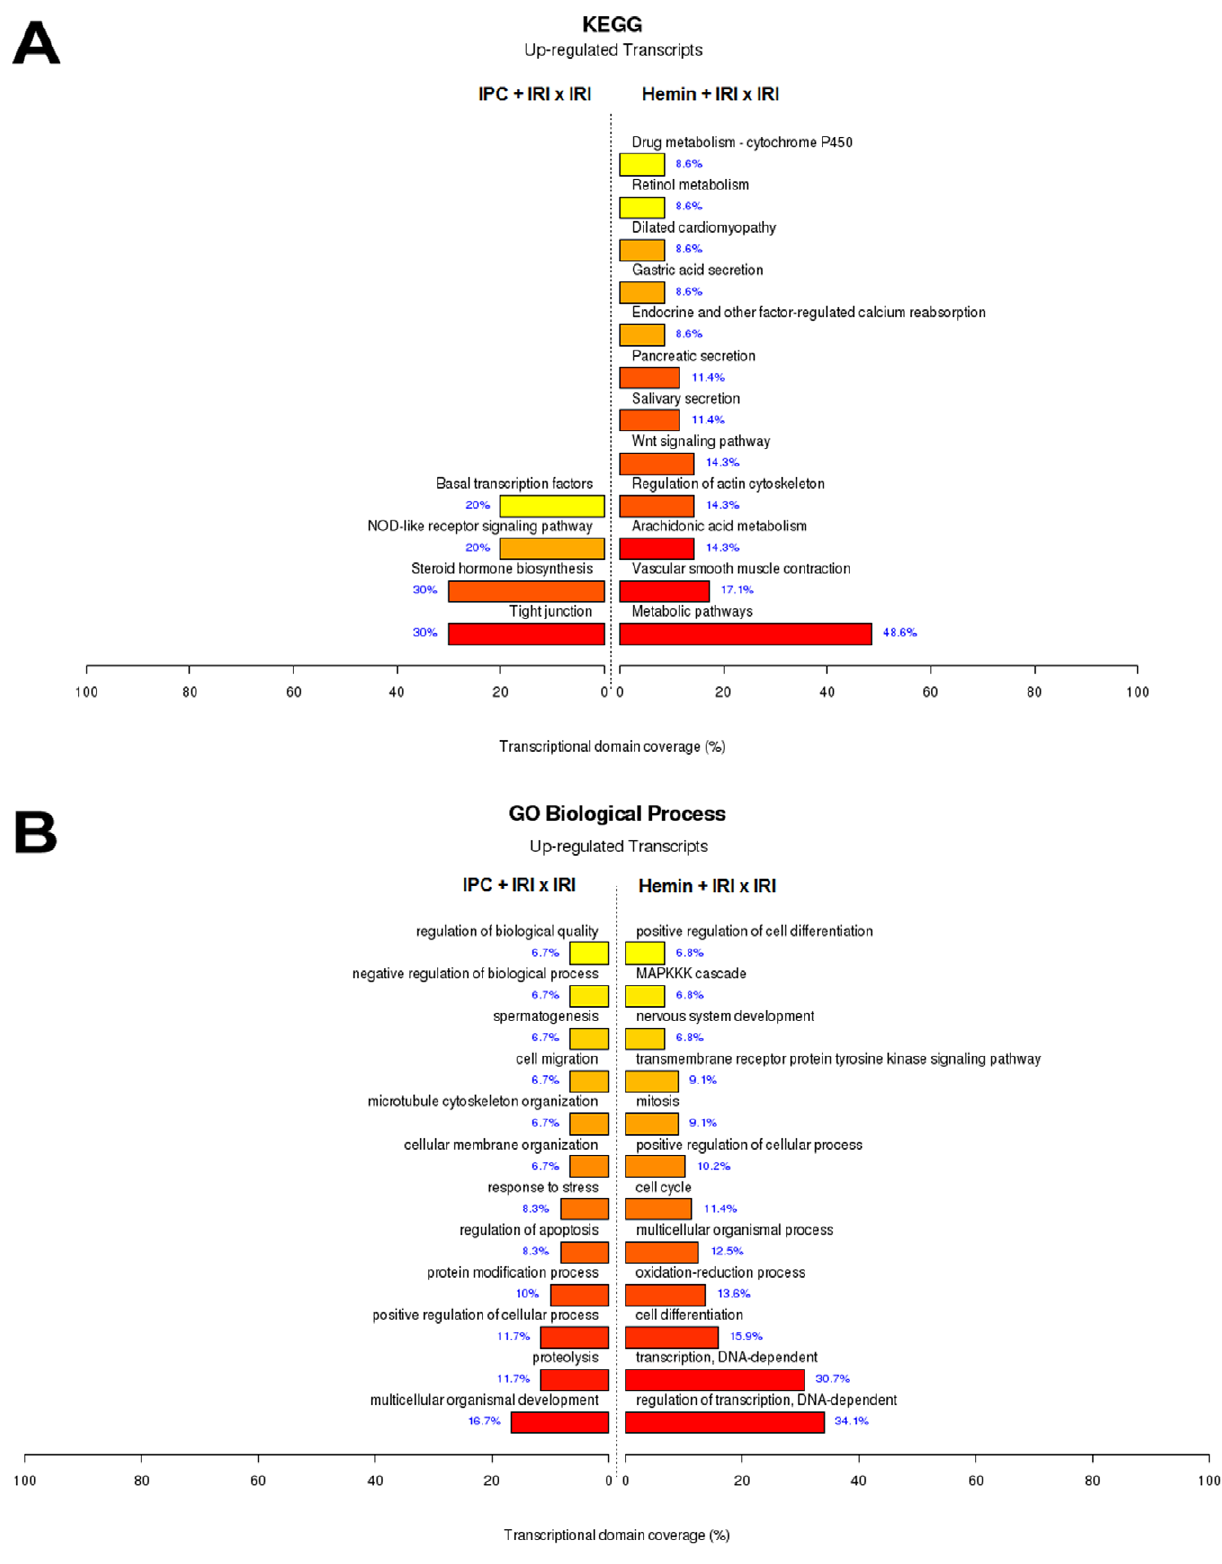
Figure 8. Top ranked biological functions of the exclusively differentially expressed genes regulated by IPC and Hemin treatment. A) KEGG categories showing significant functional enrichment of the exclusively differentially expressed genes found at IPC + IRI vs IRI and IRI + Hemin vs IRI comparisons. B) Biological Process Ontology (GO) of the exclusively differentially expressed genes found at IPC + IRI vs IRI and IRI + Hemin vs IRI comparisons. The red color of the bar plots represent up-regulated genes.